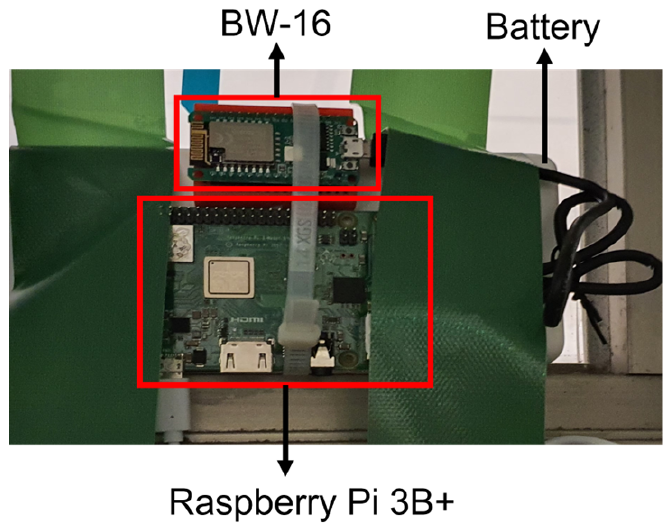
Figure 7. Device configuration for the real-world experiment.